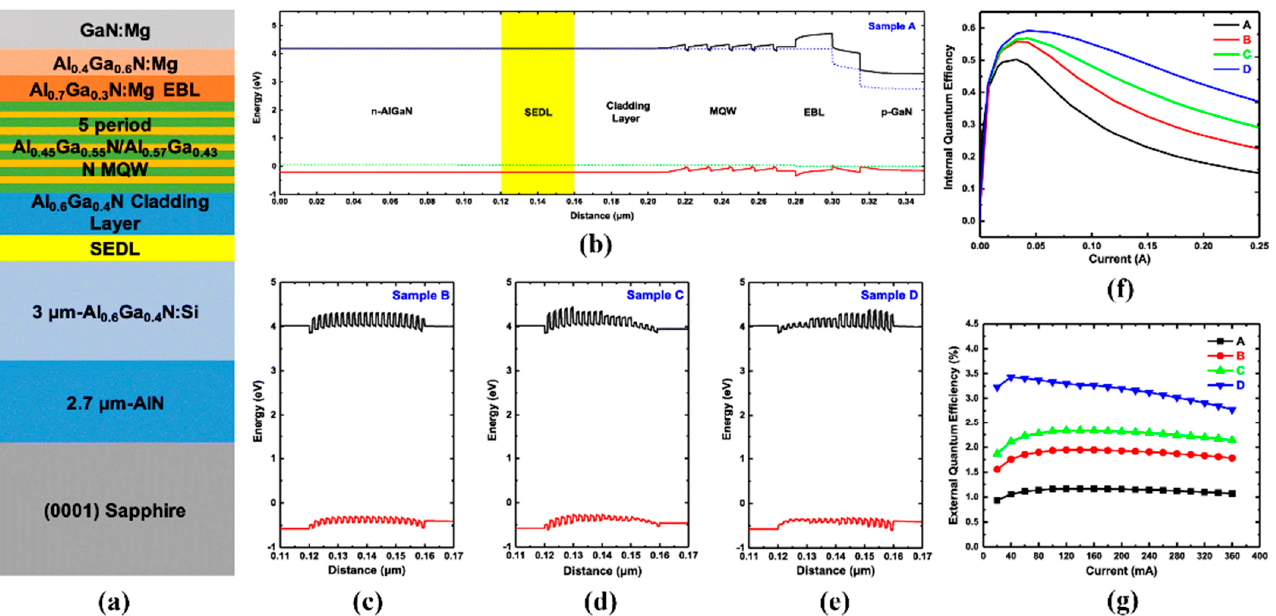
Figure 6. ( a ) Schematic of DUV LEDs. ( b ) Schematic band diagram of conventional DUV LEDs. ( c – e ) Three different superlattice electron deceleration layers. ( f ) IQE and ( g ) EQE as functions of current for the four DUV LEDs. Reproduced from Ref. [70] with permission from Springer.